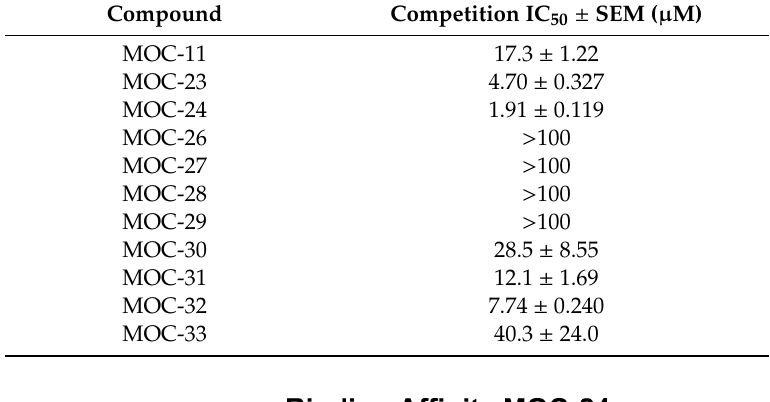
Table 1. Inhibition of NS4A 21` – 33` binding with NS3 by MOC compounds and NS3 inhibition. Standard error of mean (SEM), half maximal inhibitory concentration (IC 50 ).